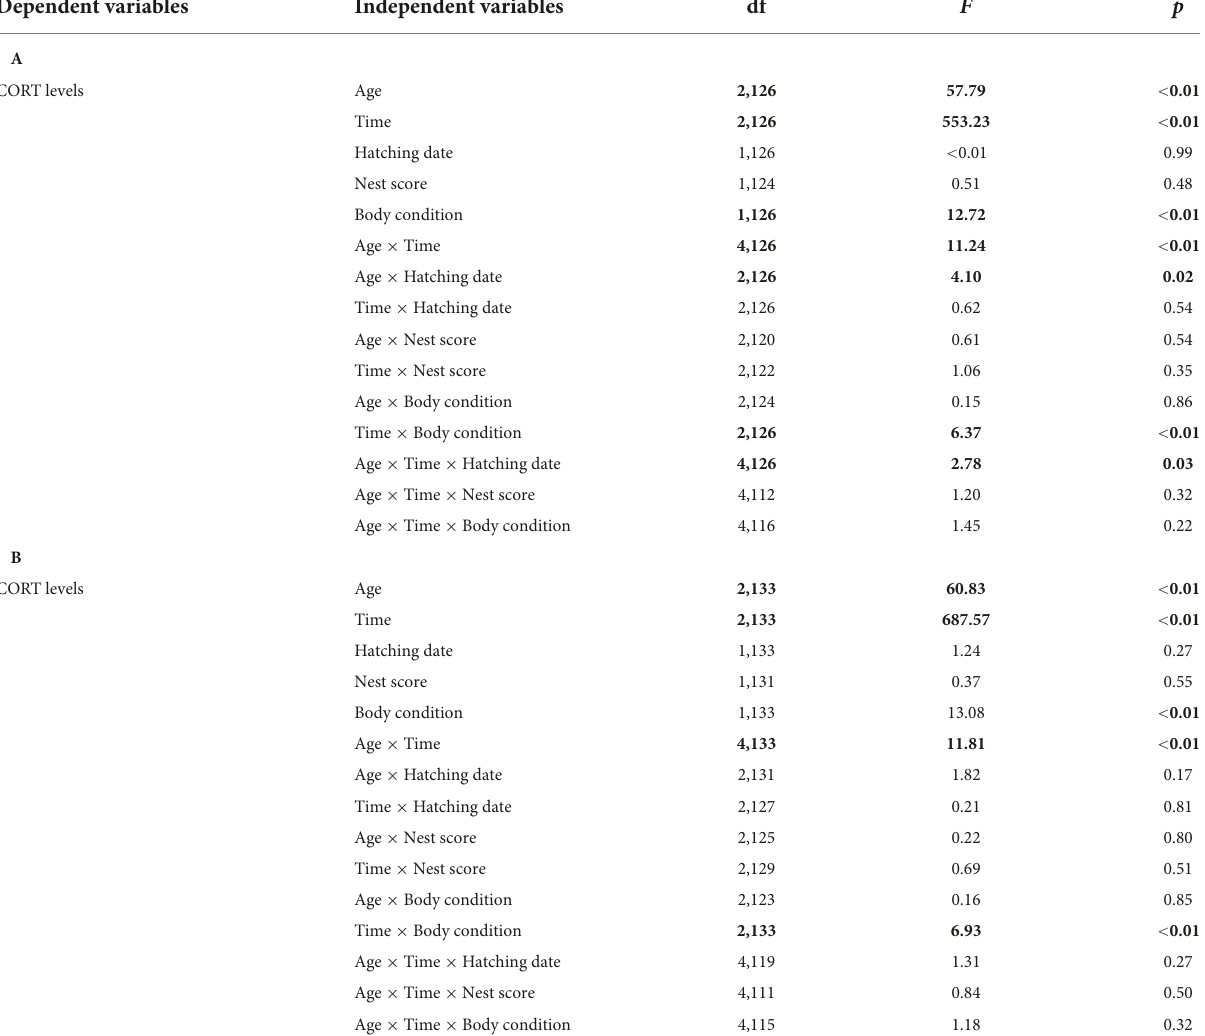
TABLE 1 Model selections to test the influence of the age of the chick (11-days old, 20-days old, 37-days old), time of sampling (baseline levels, stress-induced levels at 15 min, stress-induced levels at 30 min), body condition, hatching date, nest score, and all interactions on corticosterone